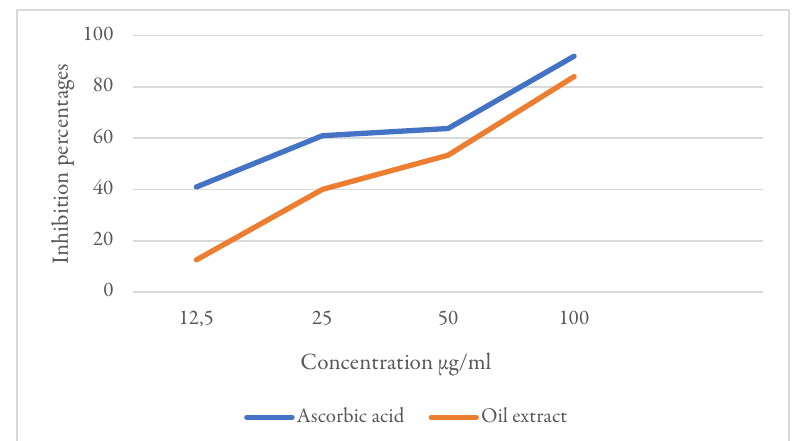
Figure 2. DPPH Free radical scavenging activities of 0FI oil extracts and ascorbic acid